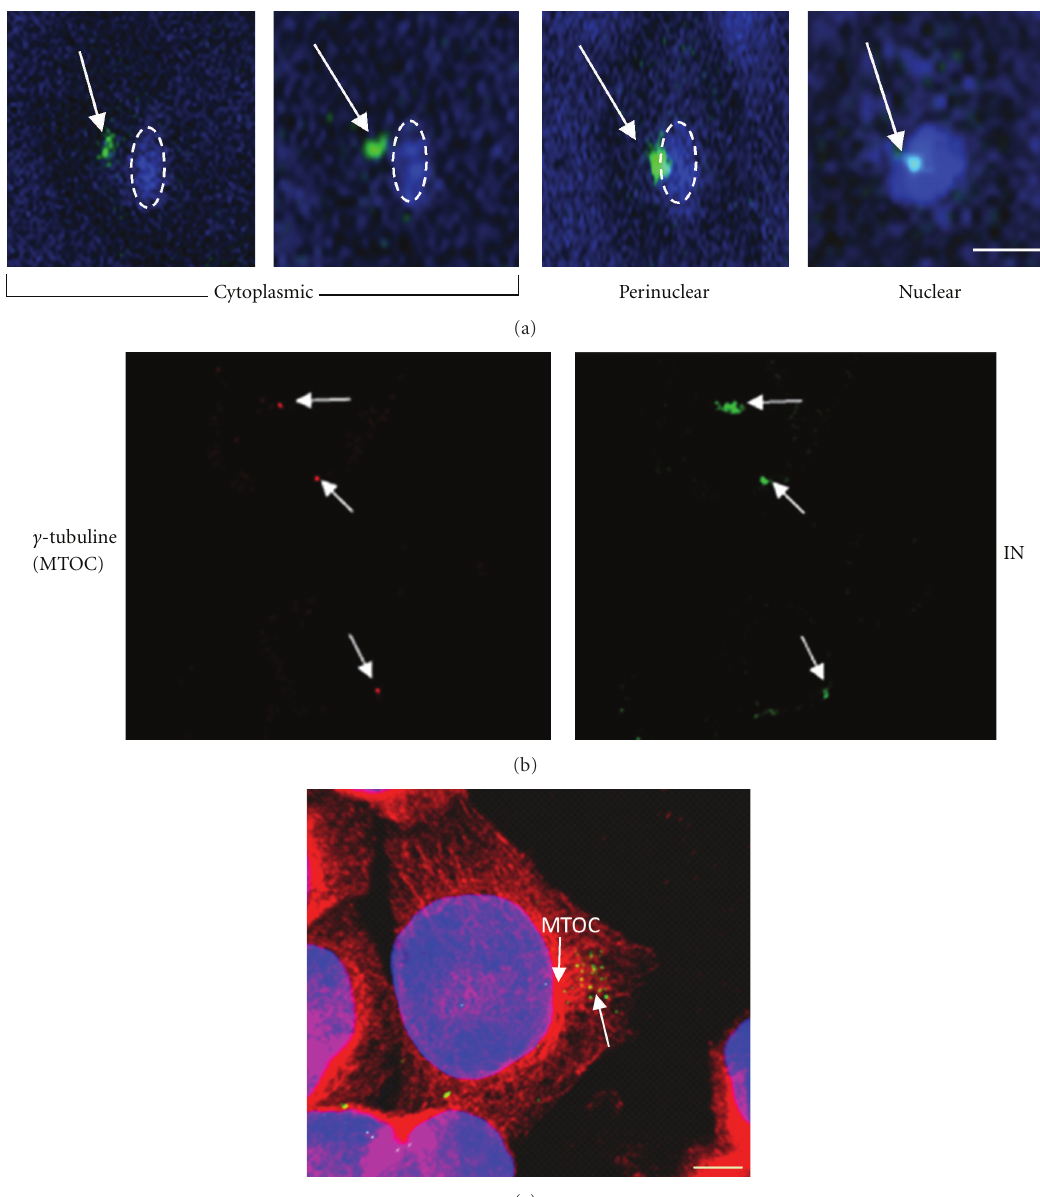
Figure 5: IN expressed in yeast and in human cell. (a) Expression of IN in yeast several times after induction. Cytoplasmic localisation: 6-7h; perinuclear localisation: 8–10 h; nuclear localisation: 30h. IN-GFP in green, nucleus in blue surrounded by dashed lanes. Barr = 1 μ m. (b) Expression of IN in H9 cells 20h after transfection. Left, MTOC in red after immunodetection of γ -tubulin (arrows). Right, IN in green immunodetected with anti-IN antibody (arrows). (c) Expression of IN in H9 cells at higher magnitude. IN in green, α -tubulin in red. Barr = 8 μ m (Desfarges, unpublished